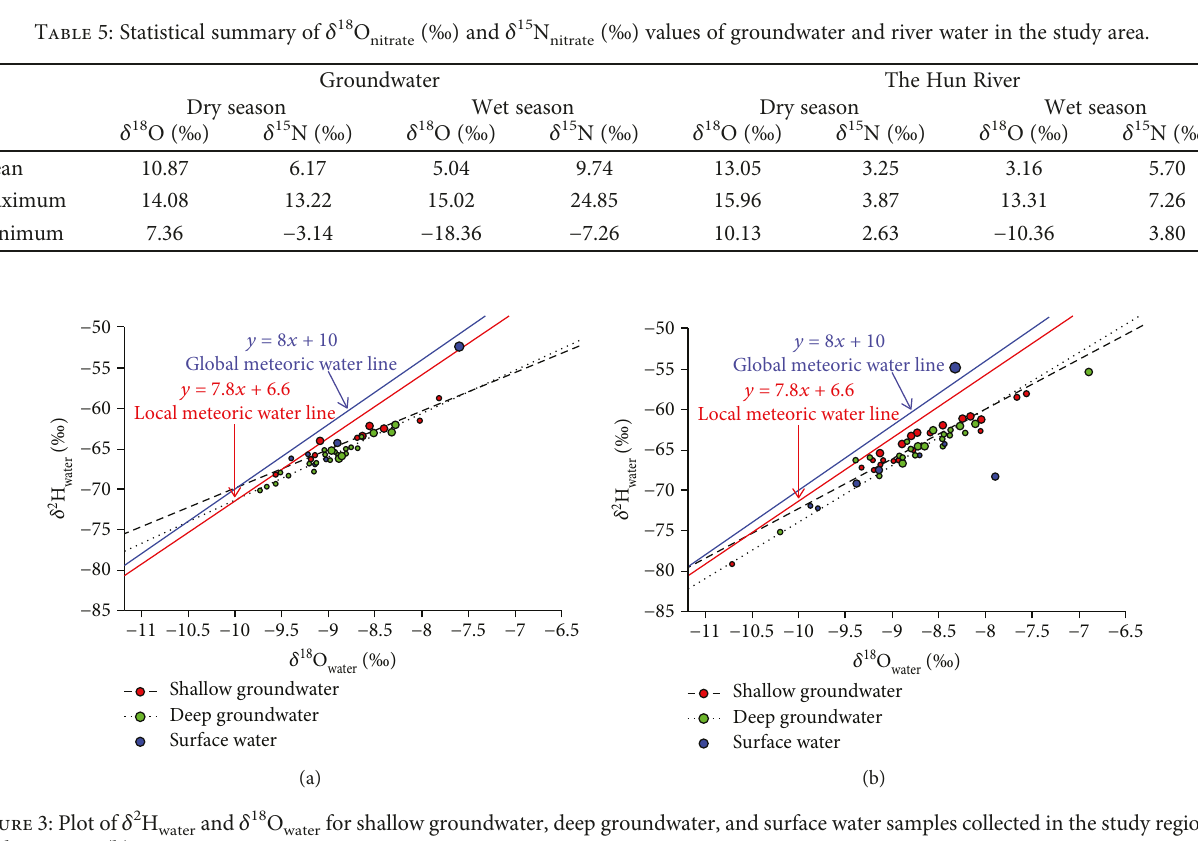
Table 4: Statistical summary of δ 18 O